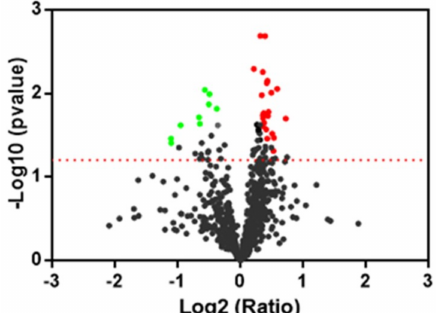
Figure 5. Protein expression profiling of oleocanthal + H 2 O 2 vs. H 2 O 2 . Scatter plot of fold change ( x axis), against log p -value ( y axis) of all quantified proteins. Up- and Down-regulated proteins are colored red and green, respectively. Dotted line indicates the threshold of